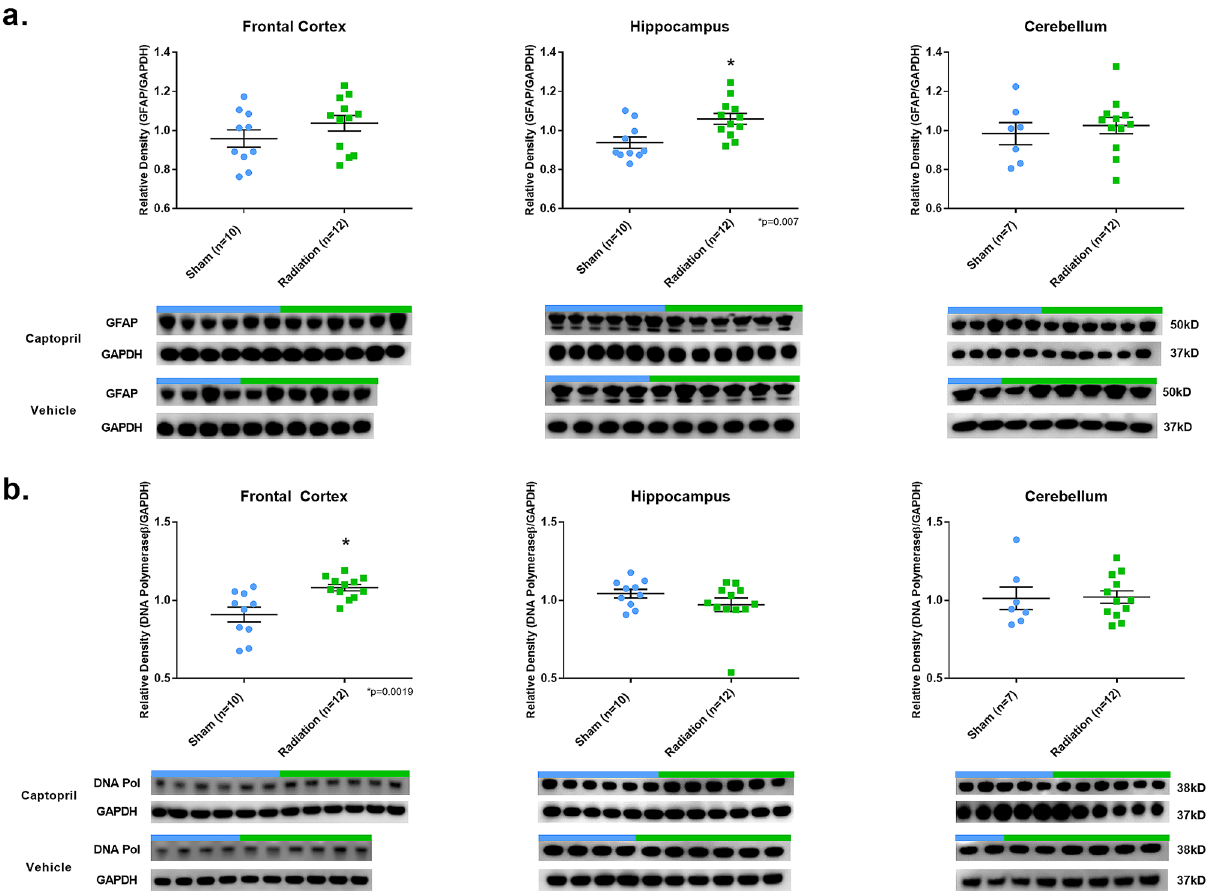
Figure 4. GFAP and DNA Polymerase-β expression in brain following total body radiation. Histograms representing the densitometric ratio of levels of GFAP ( a ) and DNA polymerase- β ( b ) with respect to GAPDH as measured in the frontal cortex, hippocampus and cerebellum in the brains of Gottingen mini-pigs 30-days after total body radiation (1.79 Gy of Cobalt [ 60 Co]) with representative western blots # for sham and radiation exposed animals treated with captopril or vehicle. There was no statistical difference between captopril or vehicle treated groups, so data was pooled for each group represented in histograms above. *indicates p values < 0.05 as determined by 2-tailed, unpaired, t -tests. Error bars represent standard error of the mean (SEM). # for full length blots for each antibody, see Supplementary Fig.